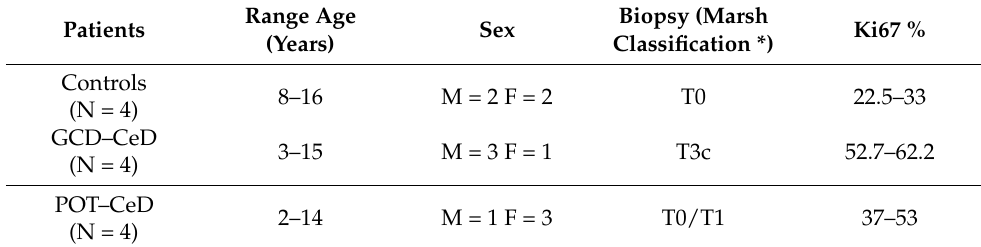
Table 3. Patients’